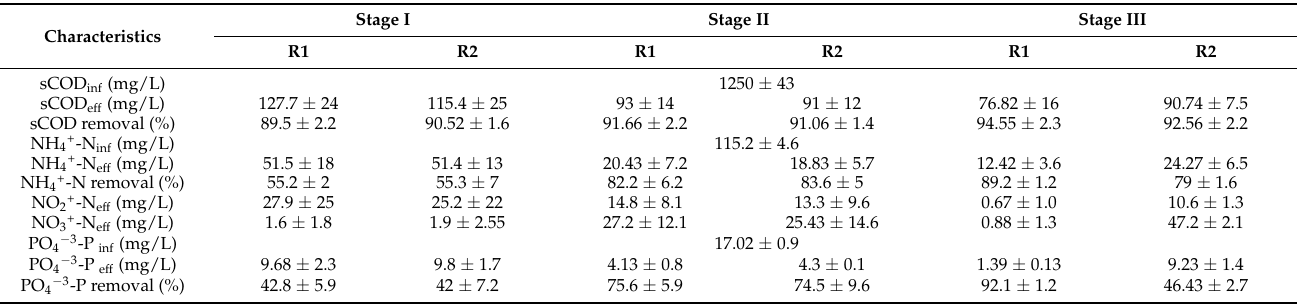
Table 2. Removal efficiencies of sCOD, NH 4+ -N, and PO 4 − 3 -P in R1 and R2.